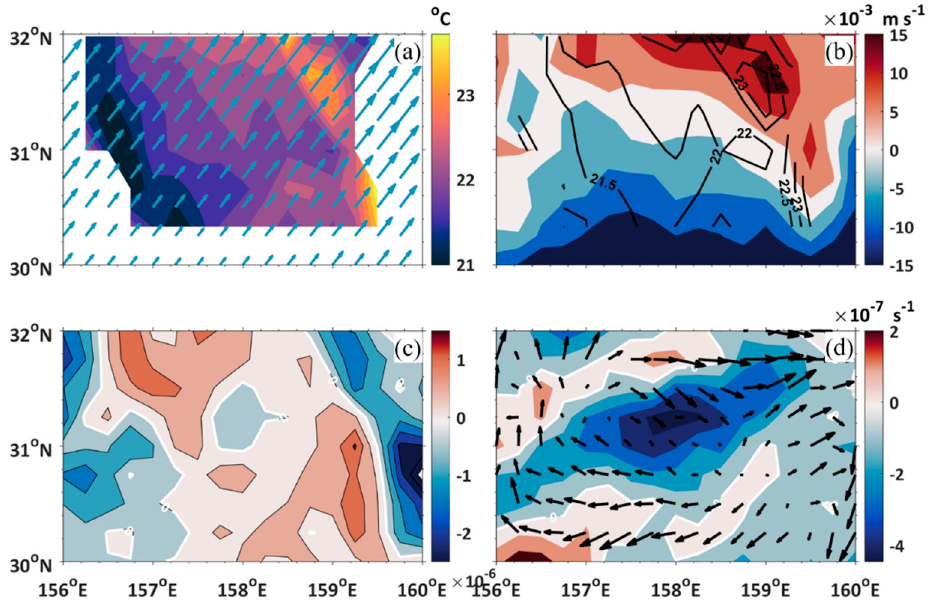
Figure 14. ( a ) The wind stress (vectors) and water temperature (color shaded) at 5 m depth. ( b ) Wind stress magnitude (shaded) and water temperature (contours). ( c ) Wind stress divergence. ( d ) Wind stress curl.